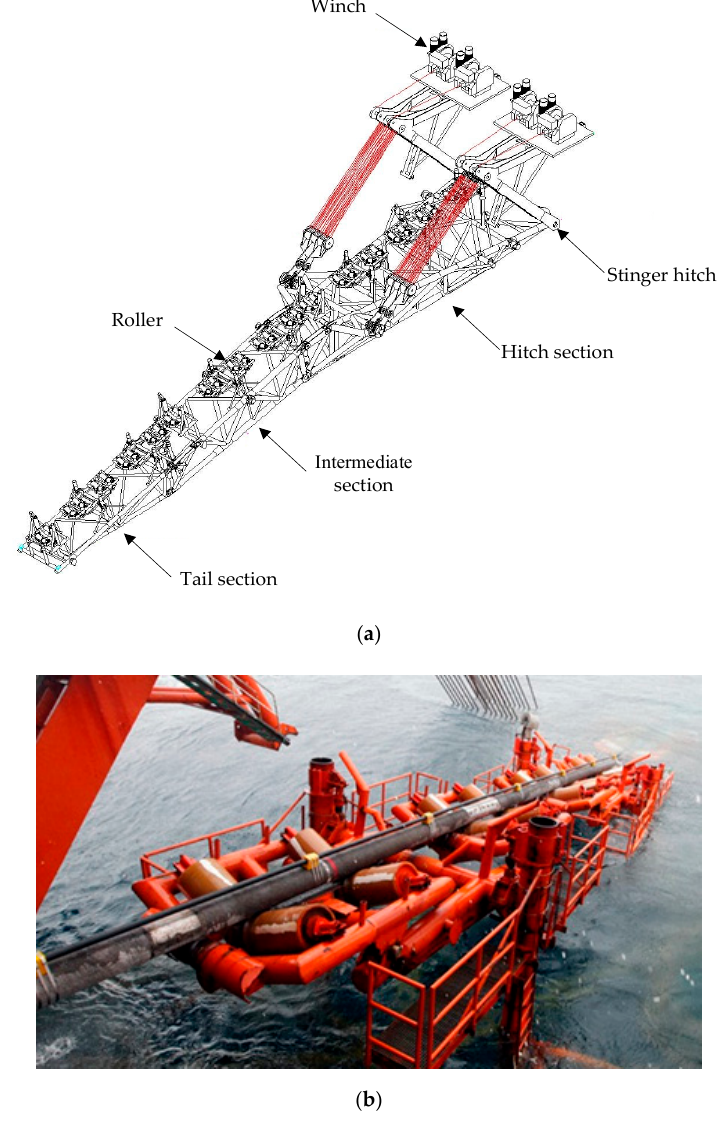
Figure 8. Stinger for S-laying operations: ( a ) articulated stinger of the HYSY201 and ( b ) the pipeline in contact with the stinger roller.